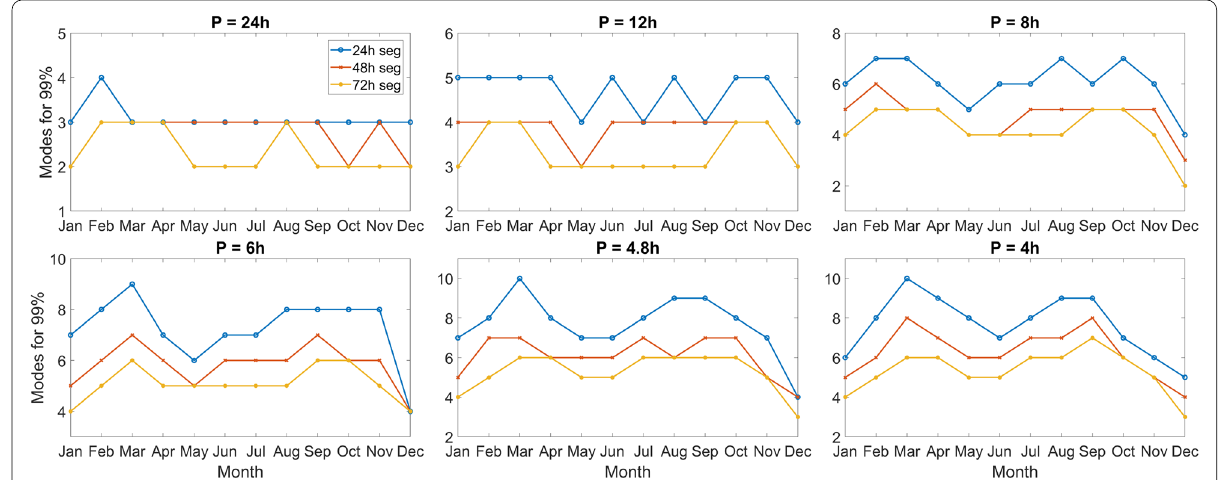
Fig. 6 Number of modes needed to explain 99% variance for each period, P months, and the FT segment length is varied between 24, 48, and 72 h. Note that January and December do not have the full months of data available, as the stream function spans